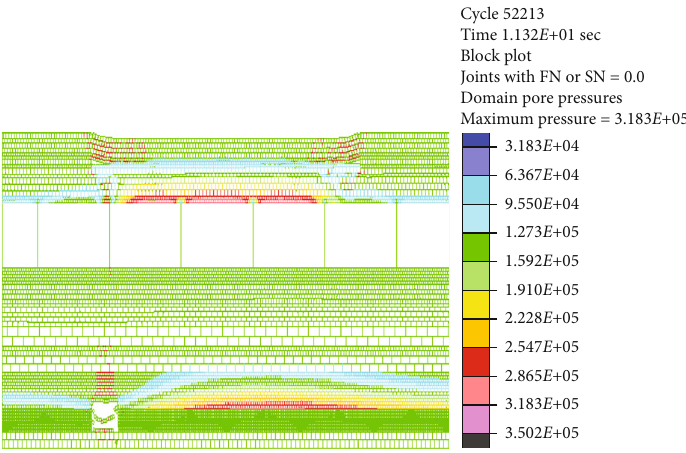
Figure 3: The pore pressure distribution in initial caving of direct roof.